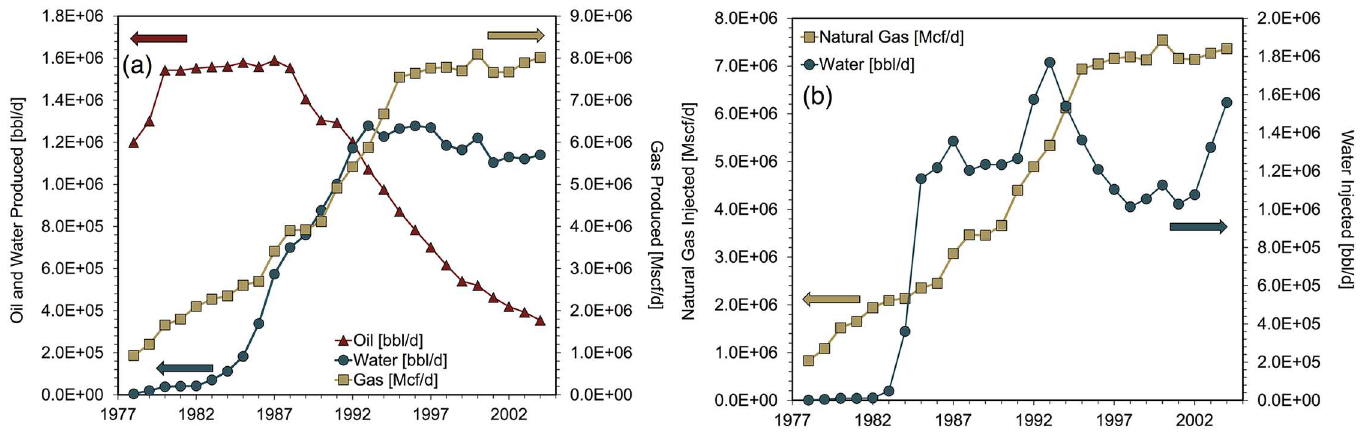
Fig 5. Prudhoe Bay input data for fluid production and injection. (a) Fluid production, (b) fluid injectionSources: [16,